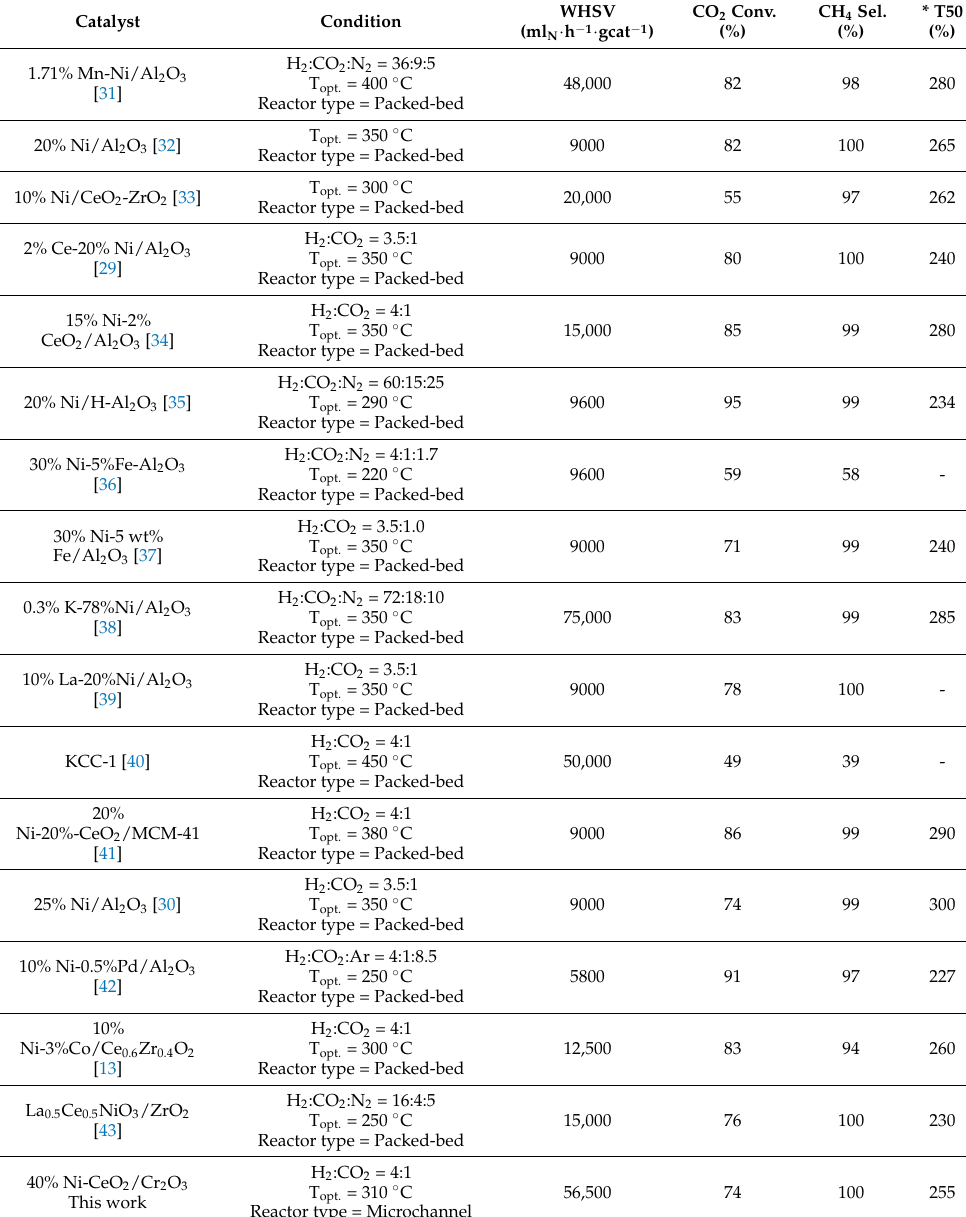
Table 1. Catalysts comparison for CO 2 methanation